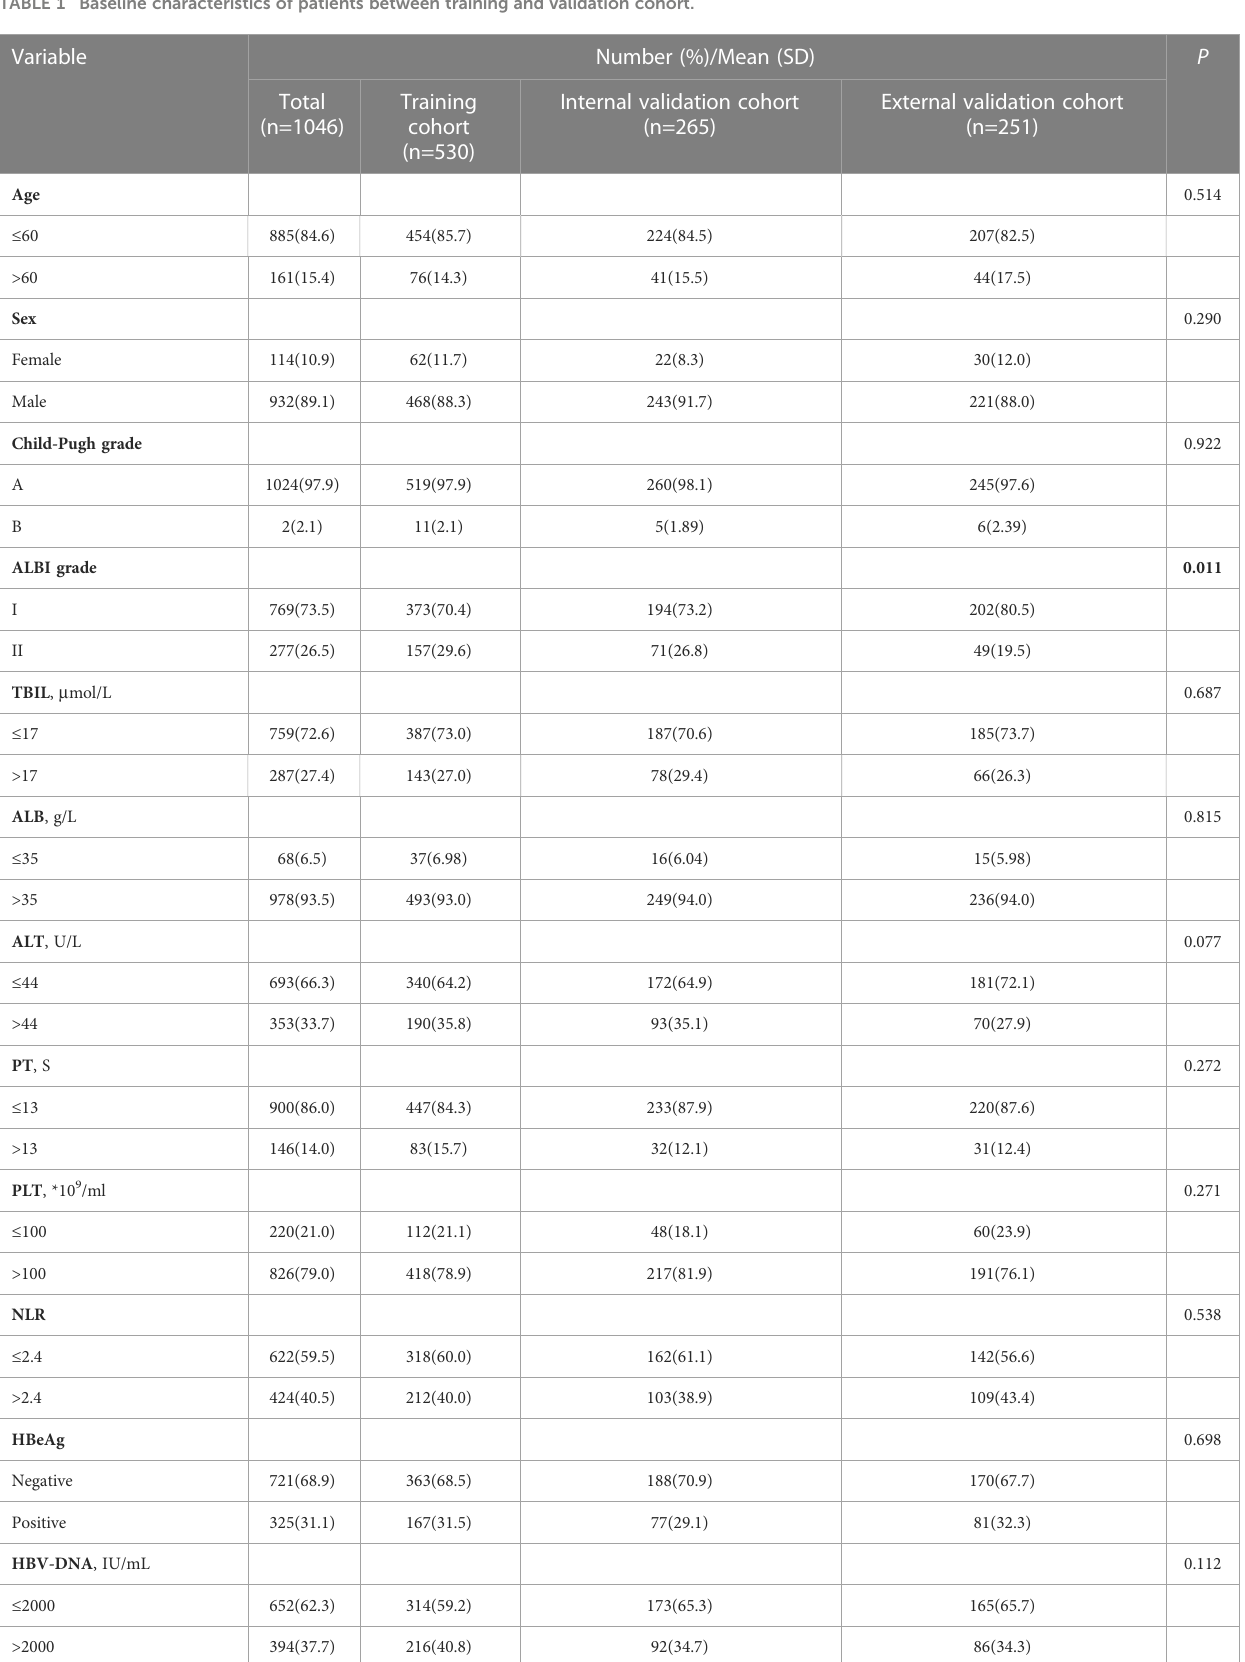
TABLE 1 Baseline characteristics of patients between training and validation